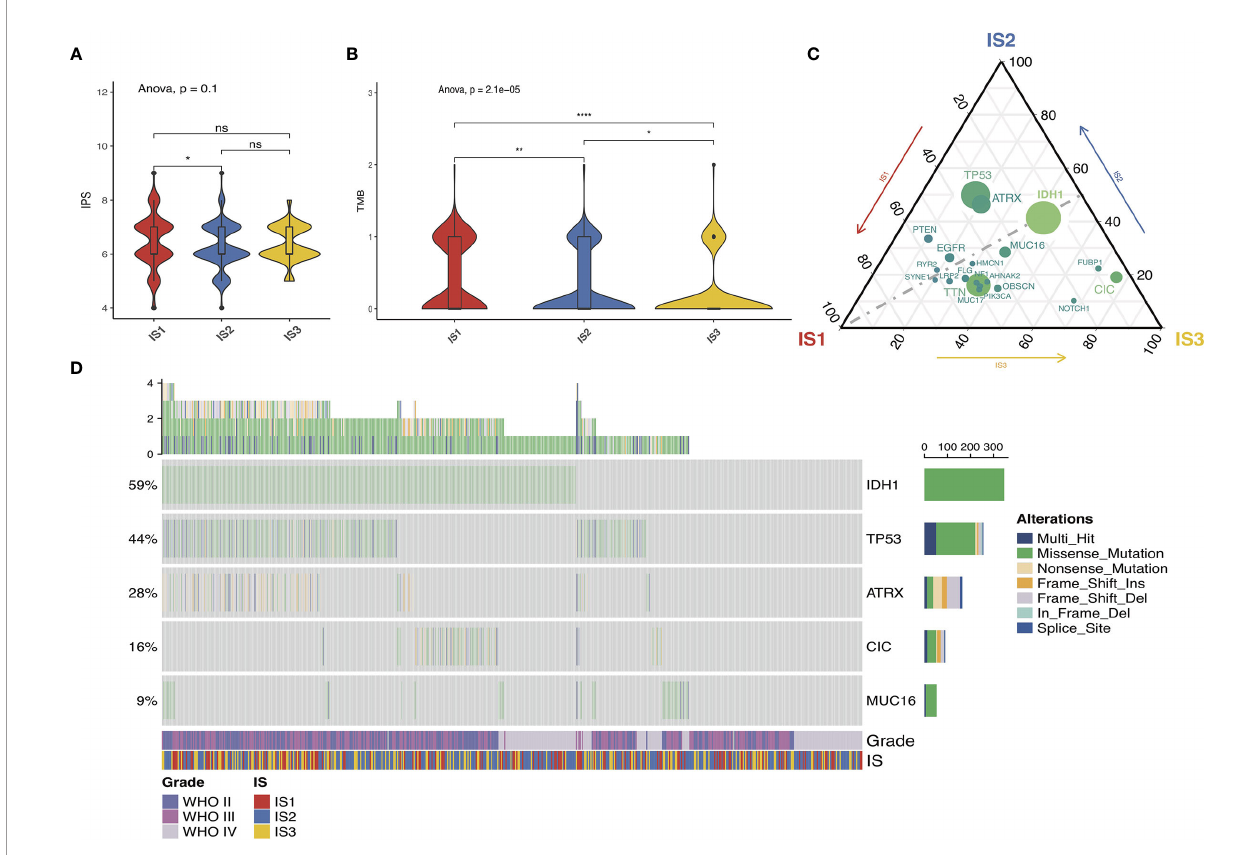
FIGURE 5 | Association between immune subtypes and mutation. IPS and TMB in IS1 – IS3 across TCGA (A, B) . Distribution of top 20 mutated genes among three immune subtypes in the TCGA (C) database. Seven highly mutated genes in glioma immune subtypes in TCGA (D) dataset. ns presents no difference, *p < 0.05, **p < 0.01, and ****p <